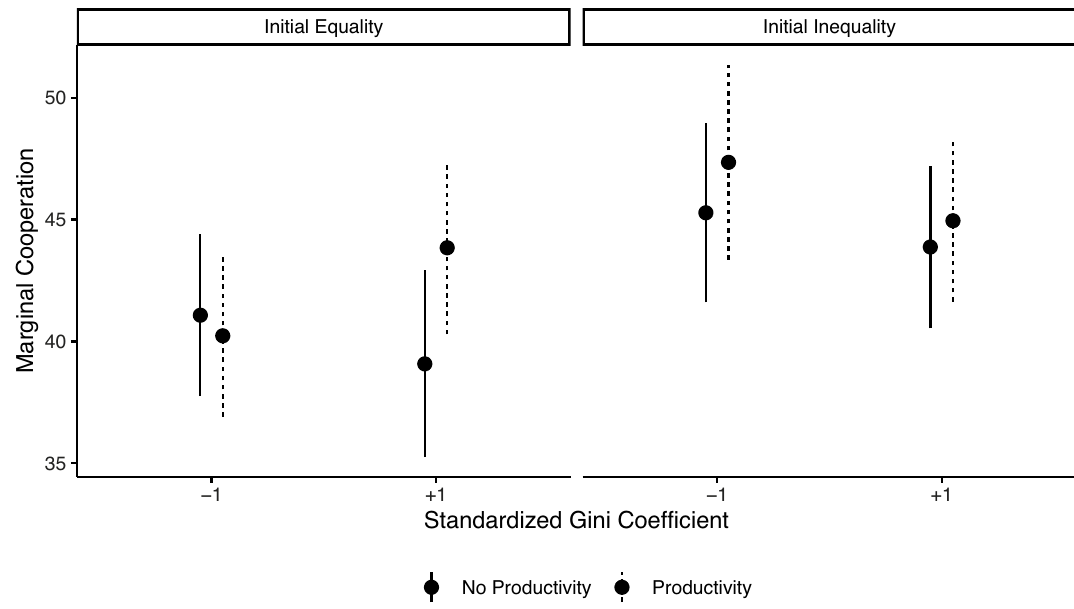
Figure 4. Marginal means from Model 3 of Table 1 illustrating the interaction between wealth productivity, baseline (manipulated) inequality, and observed network-level inequality.